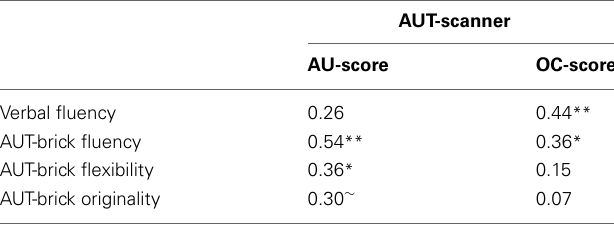
Table 2 | Bivariate correlations for fluency and creativity